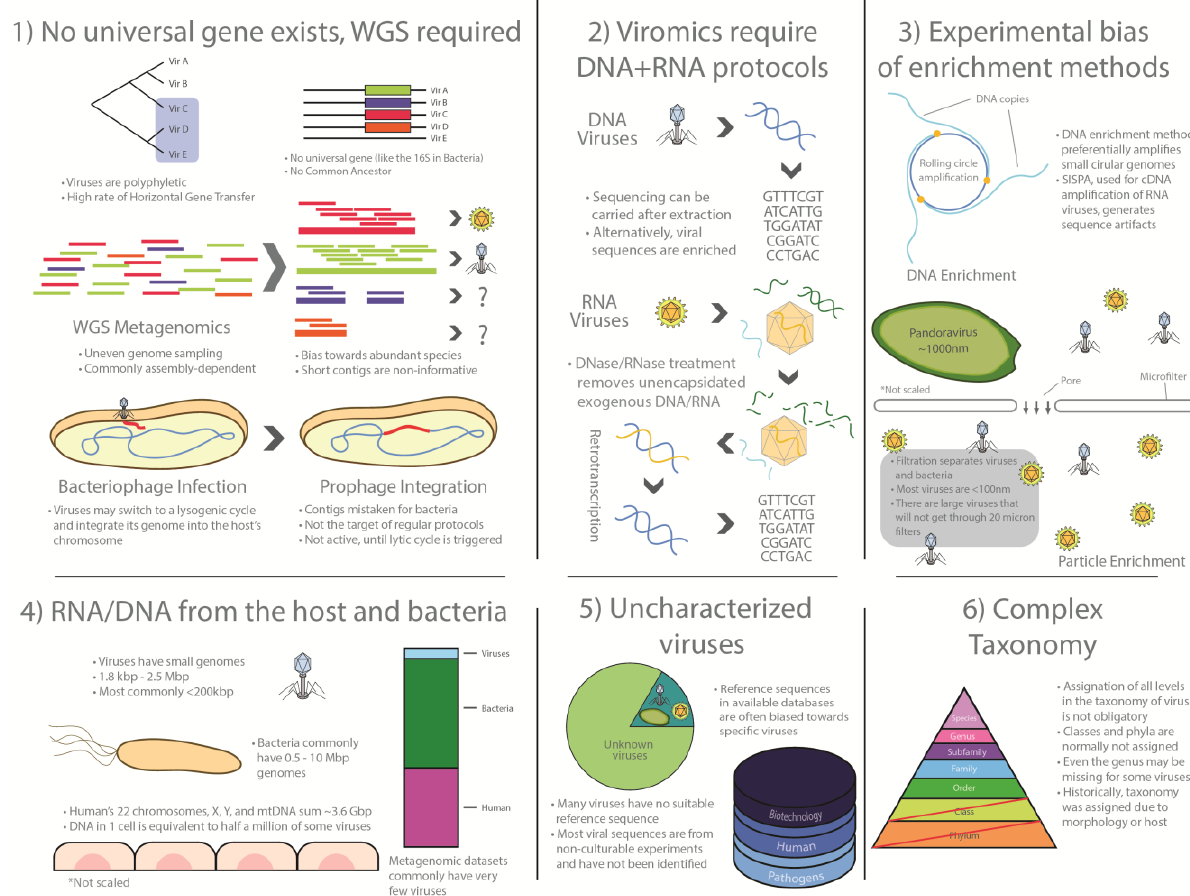
FIGURE 1: Challenges in the study of the virome . The study of viral communities faces numerous experimental limitations that are inher- ent to the study of viral particles. As viruses are polyphyletic, viromic-level phylogenies are often unreliable, further complicated by the lack of universal gene makers, a high rate of horizontal gene transfer, and the lack of a common ancestor. Viral metagenomics thus rely on the WGS framework which is commonly dependent of (yet, not restricted to) sequence assembly. This derives in additional challenges such as the formation of chimeric contigs, underrepresented fragments and species, and other general assignation issues. Additional hurdles are presented in viral RNA workflows as unencapsidated nucleic acids must be removed prior to RNA extraction, following re- trotranscription. Additional biases may be introduced by enrichment of viral particles (filtration is shown as an example) or by amplifica- tion techniques for optional DNA enrichment, such as the rolling circle amplification. Niche ecology may also affect the recovery of viral sequences, as nucleic acids from the host and its bacteria are abundant in sample preparation and are often sequenced unintentionally. Moreover, suitable viral reference sequences are often missing from public sequence databases. Plus, several of those that exist lack a proper functional characterization or taxonomic assignation and databases are commonly biased towards specific species with pathogen- ic or biotechnological potential. Furthermore, current viral taxonomy is convoluted, with a large proportion of viruses having inaccurate or missing taxonomic labels, often derived from morphology or feature-based assignations. Together, these challenges have hindered the advance of viromics in the past decade, representing a hefty entry barrier for the scientific community due to the increased time, exper- tise, and resources that are required by these studies with respect to their bacterial OPEN ACCESS | www.microbialcell.com 379 Microbial Cell | SEPTEMBER 2019 | Vol. 6 No. 9